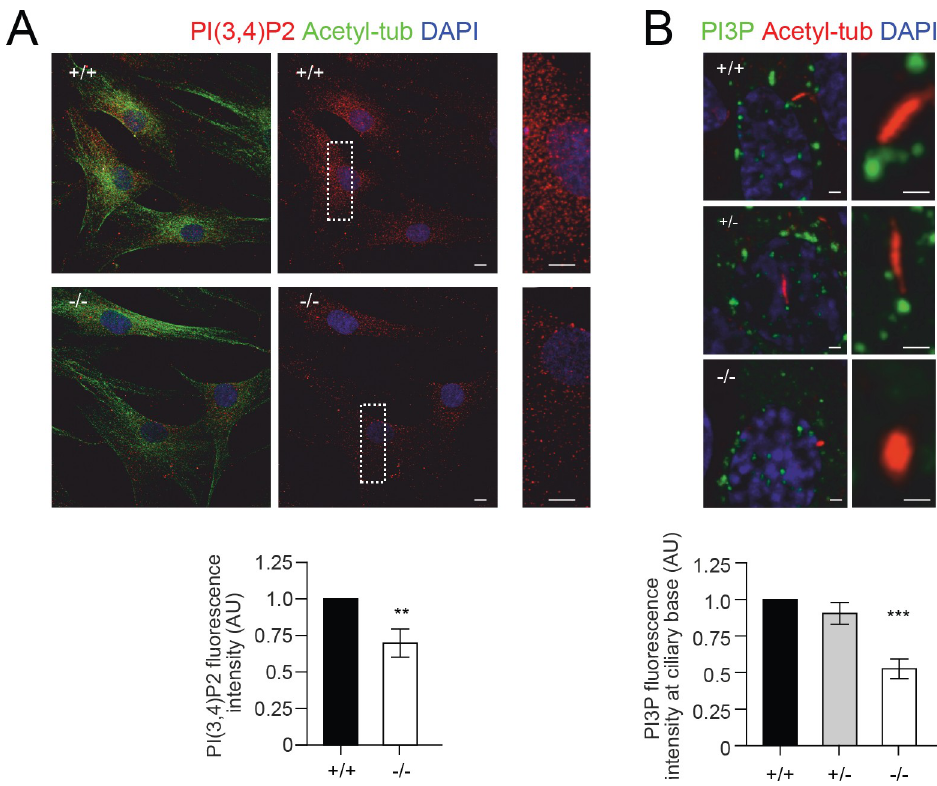
Fig 3. Impaired PI metabolism in patient-derived fibroblasts. Quantification of PI(3,4)P2 and PI(3)P were analysed and normalized on whole cell fluorescence. (A) Immunofluorescence analysis of cellular PI(3,4)P2 levels. Results showed that PI(3,4)P2 is significantly reduced throughout the cell in -/- cells compared with +/+ cells. n = 4 independent experiments and 10 cells per genotype for each experiment (S6 Table). (B) Immunofluorescence analysis of PI(3)P localization at the base of the primary cilium. Results showed that PI(3)P is significantly reduced at the base of the primary cilium in -/- cells compared with +/+ and or +/- cells. n = 3 independent experiments and 15 cells per genotype for each experiment (S6 Table). Nuclei are stained with DAPI. �� indicates p < 0.01. ��� indicates p <